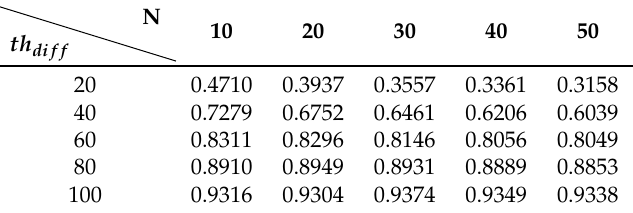
Table 2. Average precision with different th dif f and N .